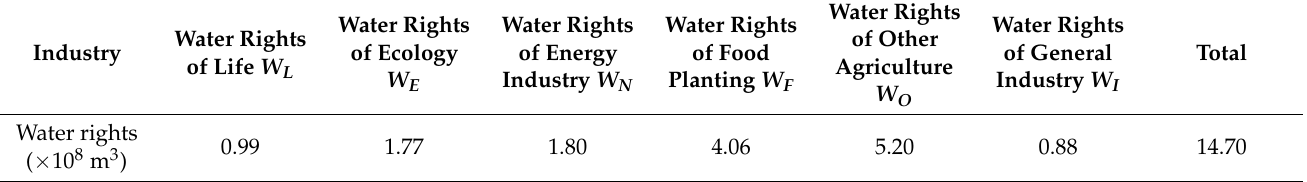
Table 2. Water rights allocation scheme of the coordinated development of water–ecology–energy– food in